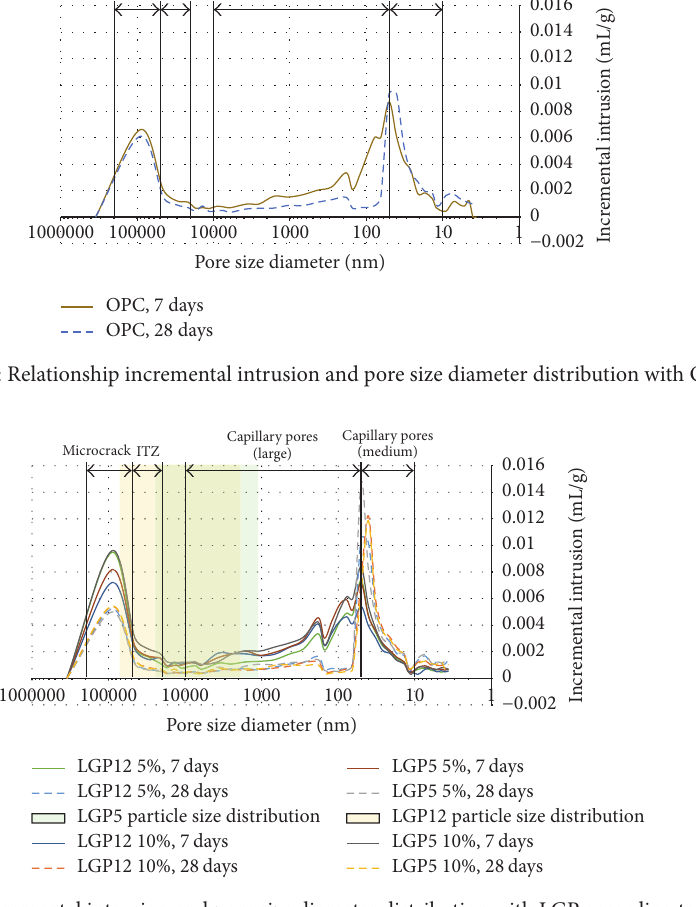
Figure 16: Relationship incremental intrusion and pore size diameter distribution with LGP according to replacement and